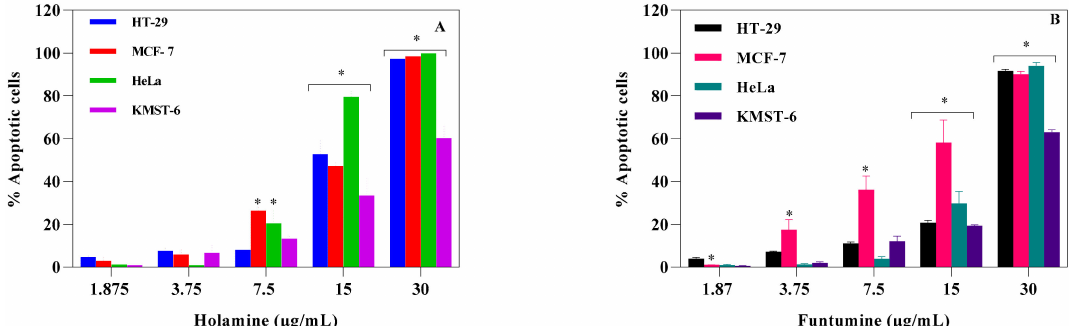
Figure 5. Apoptotic e ff ects of holamine ( A ) and funtumine ( B ) on HT-29, MCF-7, HeLa and KMST-6 cell lines. Cells were stained with the APOPercentage ™ dye and evaluated by flow cytometry. Each bar represents the mean ± SEM of triplicate experiments. The * indicates statistical significance at p < 0.05 among the cell lines for each concentration—i.e., for the apoptosis result in Panel A , the e ff ect elicited by 7.5 µ g / mL of holamine is significantly higher in MCF-7 and HeLa cells compared with HT-29 and KMST-6. The same statistical analogy holds for Panel B